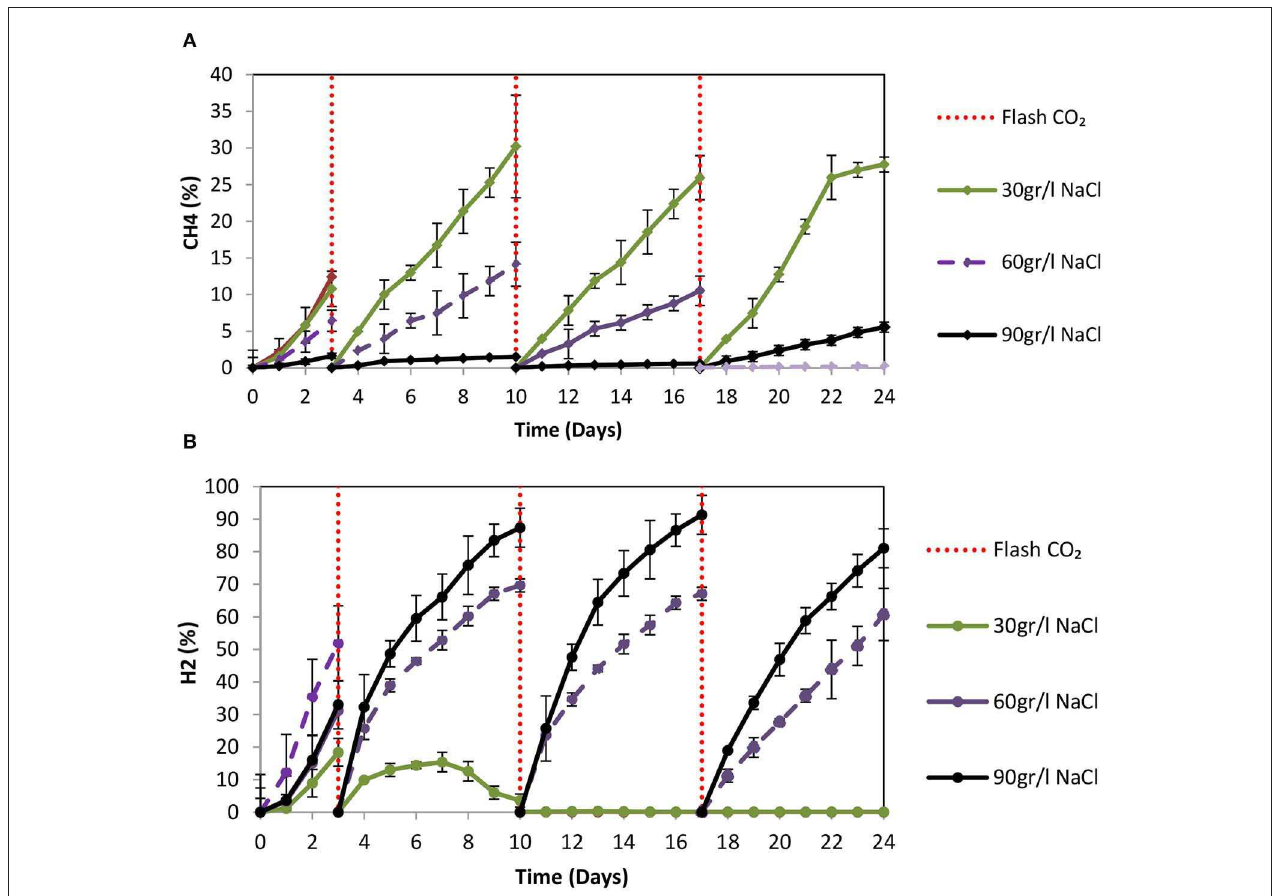
FIGURE 10 | (A) CH 4 (%) production over time by anaerobic granular sludge exposed to 100g ZVI/L and salinity of 30, 60, and 90g NaCL/L. (B) H 2 (%) production over time by anaerobic granular sludge exposed to 100g ZVI/L and salinity of 30, 60, and 90g NaCL/L.